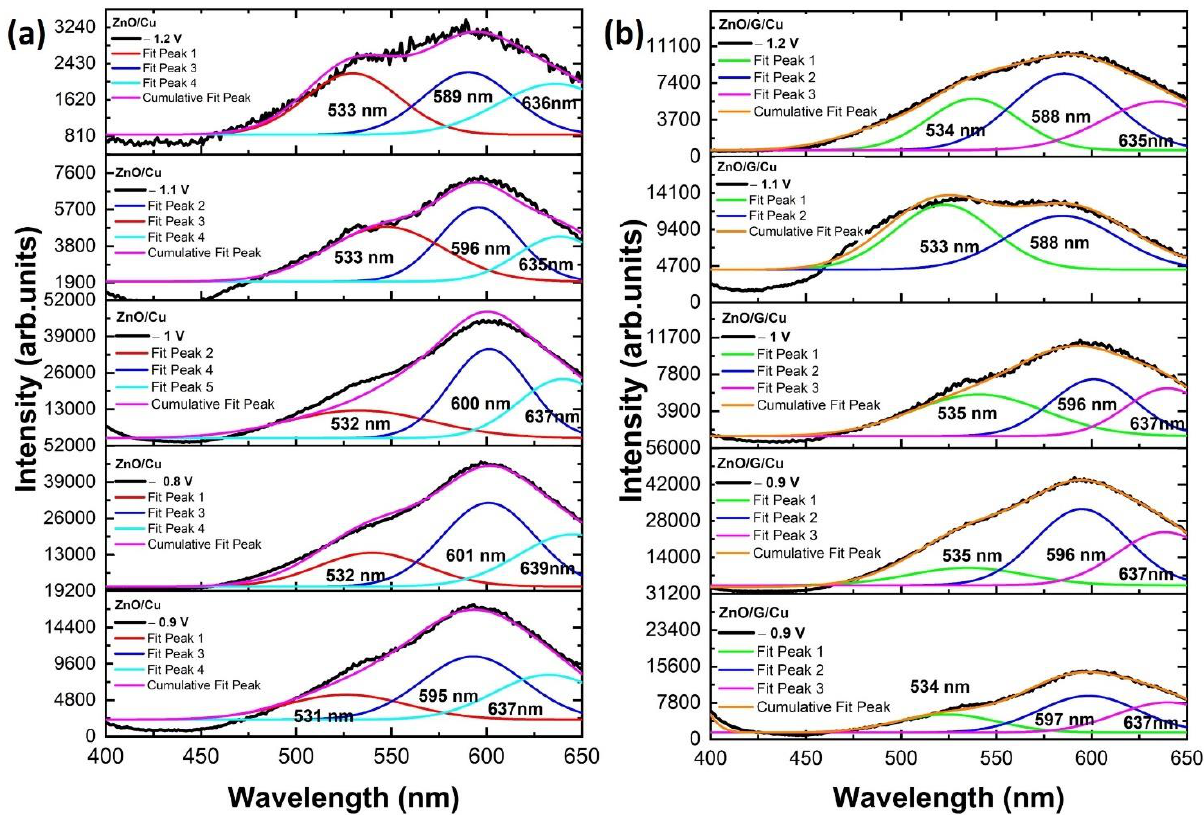
Figure 13. Gaussian fitting of the PL spectra of ( a ) ZnO/Cu, ( b ) ZnO/G/Cu films obtained using different applied potentials (black and color lines represent the experimental and the fitted data, respectively).